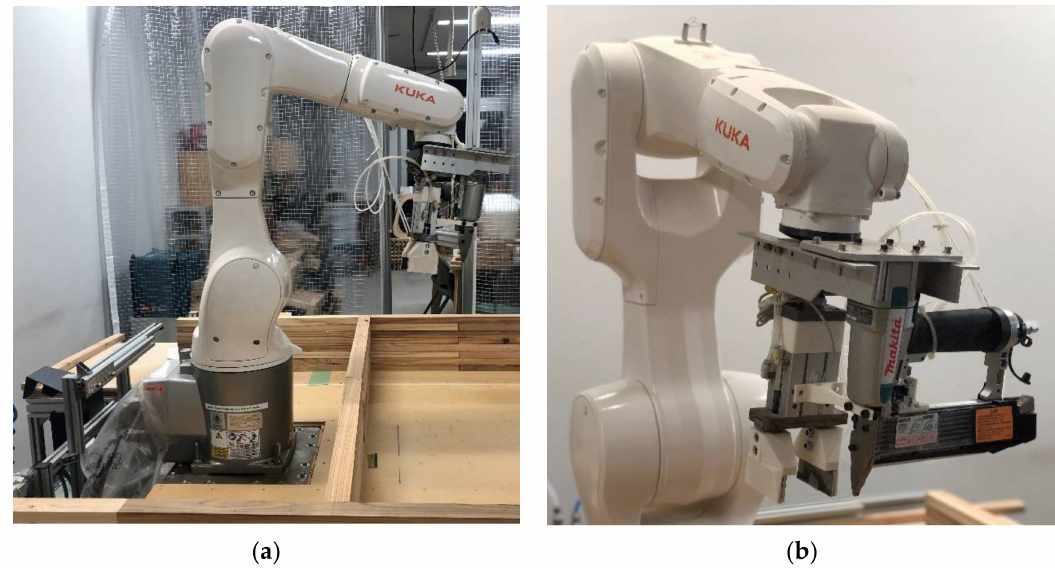
Figure 2. The construction robotic set-up is customized for the fabrication of wooden building: the KUKA robot with an arm operating radius of 0.9 m ( a ) which is equipped with an end effector ( b